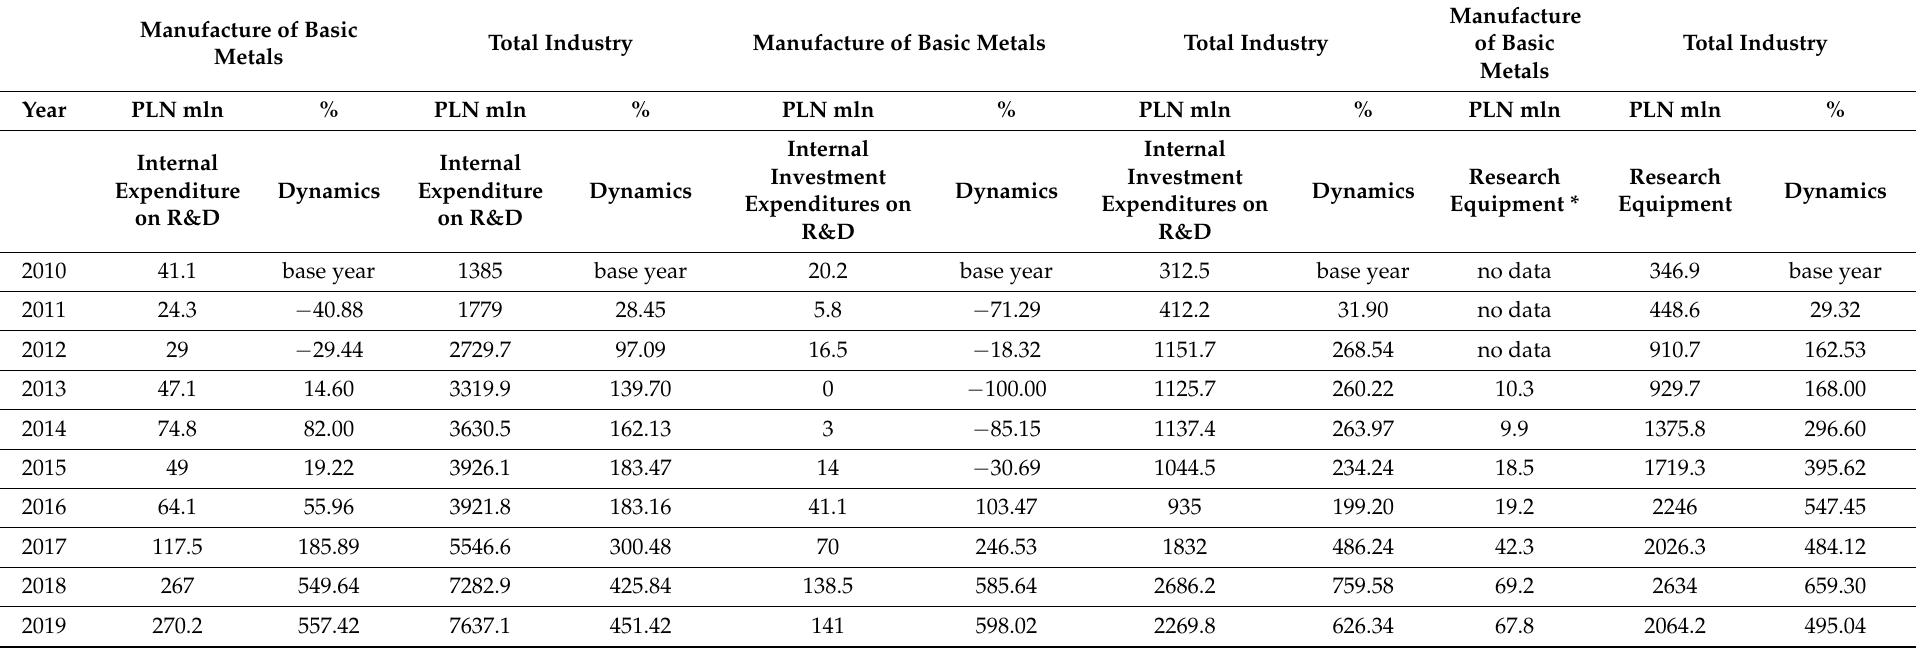
Table 5. R&D from 2010 to 2019—analysis of expenditures and dynamics for basic year